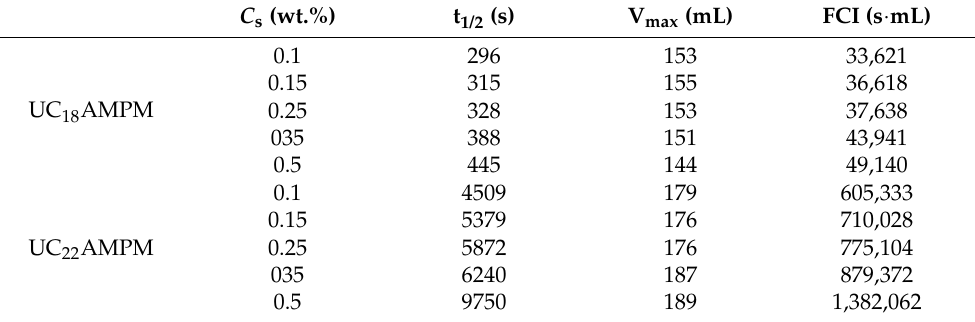
Table 1. CO 2 foam performance with different concentrations of UC 22 AMPM and UC 18 AMPM, re- spectively.